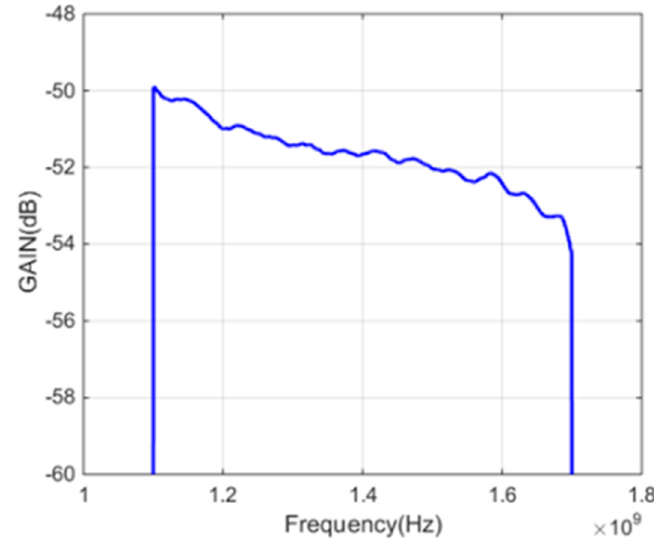
Figure 4. Amplitude–frequency characteristic of L-band channel.